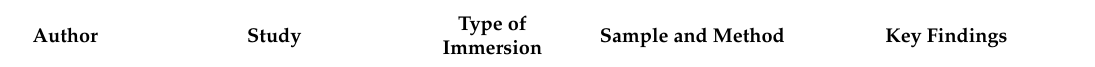
Table 1. Overview of immersion studies in the food and dining